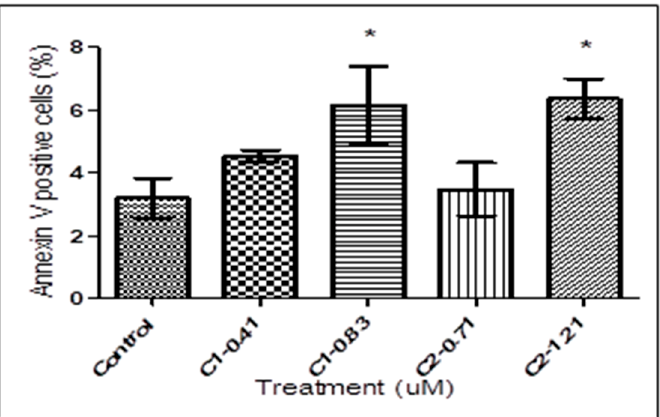
Figure 3. Fluorescence-activated cell sorting (FACS) analysis for PS exposure, measured by double staining with annexin V and PI in T. b. rhodesiense . Trypanosomes were treated with 1 at 0.41 and 0.83 µ M and 2 at 0.71 and 1.21 μ M for 72 h. An increased in annexin V-positive cells in treated trypanosomes (IC 90 ) compared with untreated controls. The bars represent the means ± SD of three independent experiments. The asterisks indicate significant differences between the treated and untreated groups calculated by one-way ANOVA with Tukey post-test (* p < 0.05). UL, upper left; UR, upper right; LL, lower left; LR, lower right; C, compound.